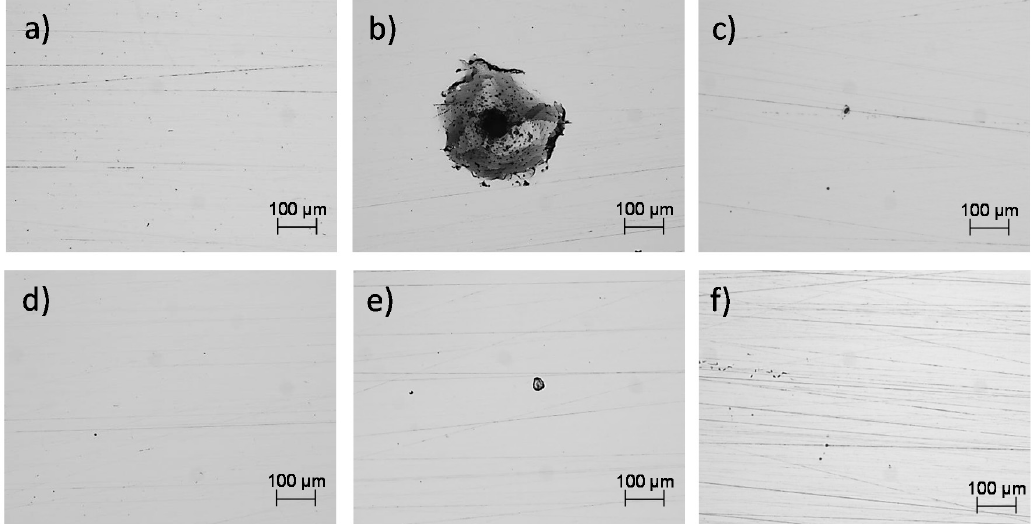
Figure 12. Morphologies of the specimens after the electrochemical tests. Optical microscope at 100X. XY plane: ( a ) H 2 O, ( b ) NaCl, and ( c ) H 2 SO 4 ; XZ plane: ( d ) H 2 O, ( e ) NaCl, and ( f ) H 2 SO 4 .